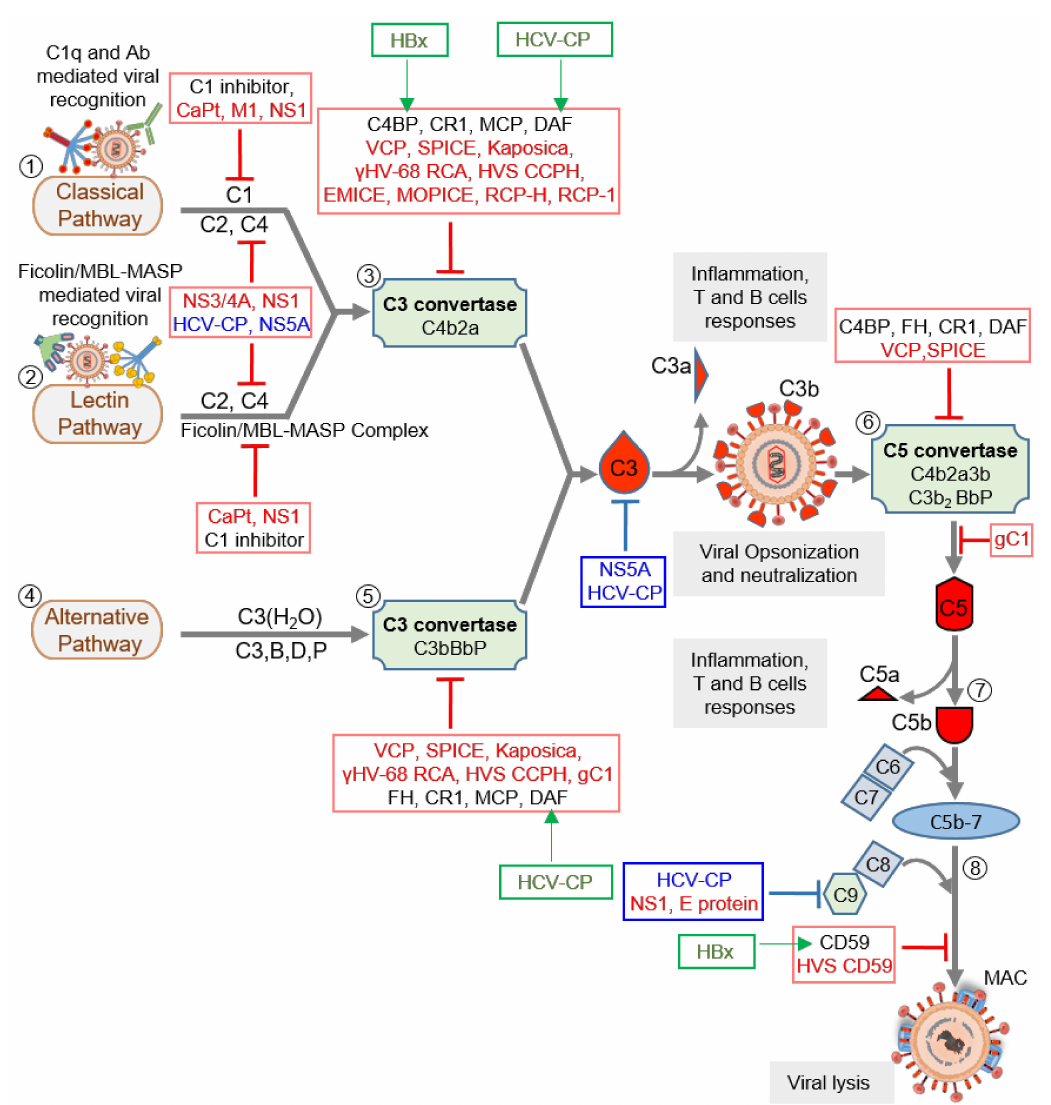
Figure 2. Complement activation and its regulation by host regulators and virally encoded molecules. Viruses can activate the host complement system by three major pathways: classical pathway (CP), lectin pathway (LP), and alternative pathway (AP). (1) In CP activation, viruses are known to be recognized by C1q and antibody. (2) In LP activation, viruses are recognized by the Ficolin/MBL-MASP complex. (3) Recognition is followed by activation of C1 and Ficolin/MBL complexes, in CP and LP respectively, which results in the cleavage of C4 and C2 and formation of C3 convertase C4b2a. The convertase then cleaves C3 into C3a and C3b. The latter opsonizes viral particles. (4) In AP, viruses are recognized directly by C3b molecules, which are generated by the initial C3 convertase C3(H2O)Bb. (5) The surface-bound C3b molecules then trigger the formation of C3 convertase C3bBb with the help of factors B and D, which is stabilized by properdin (P). The C3 convertases formed then cleaves more C3 to opsonize viral particles. (6) When C3b is attached to the preformed C3 convertase (C4b2a or C3bBbP), it is converted into C5 convertase (C4b2a3b or C3b2BbP) which is capable of cleaving C5 into C5a and C5b. (7) The newly formed C5b combines C6 and C7 to form a C5b-7 trimer that can attach to the viral surface. (8) Binding of the trimer to C8 and C9 followed by polymerization of C9 results in the formation of the membrane attack complex (MAC) that induces virolysis. These pathways are regulated at various steps by host complement regulators